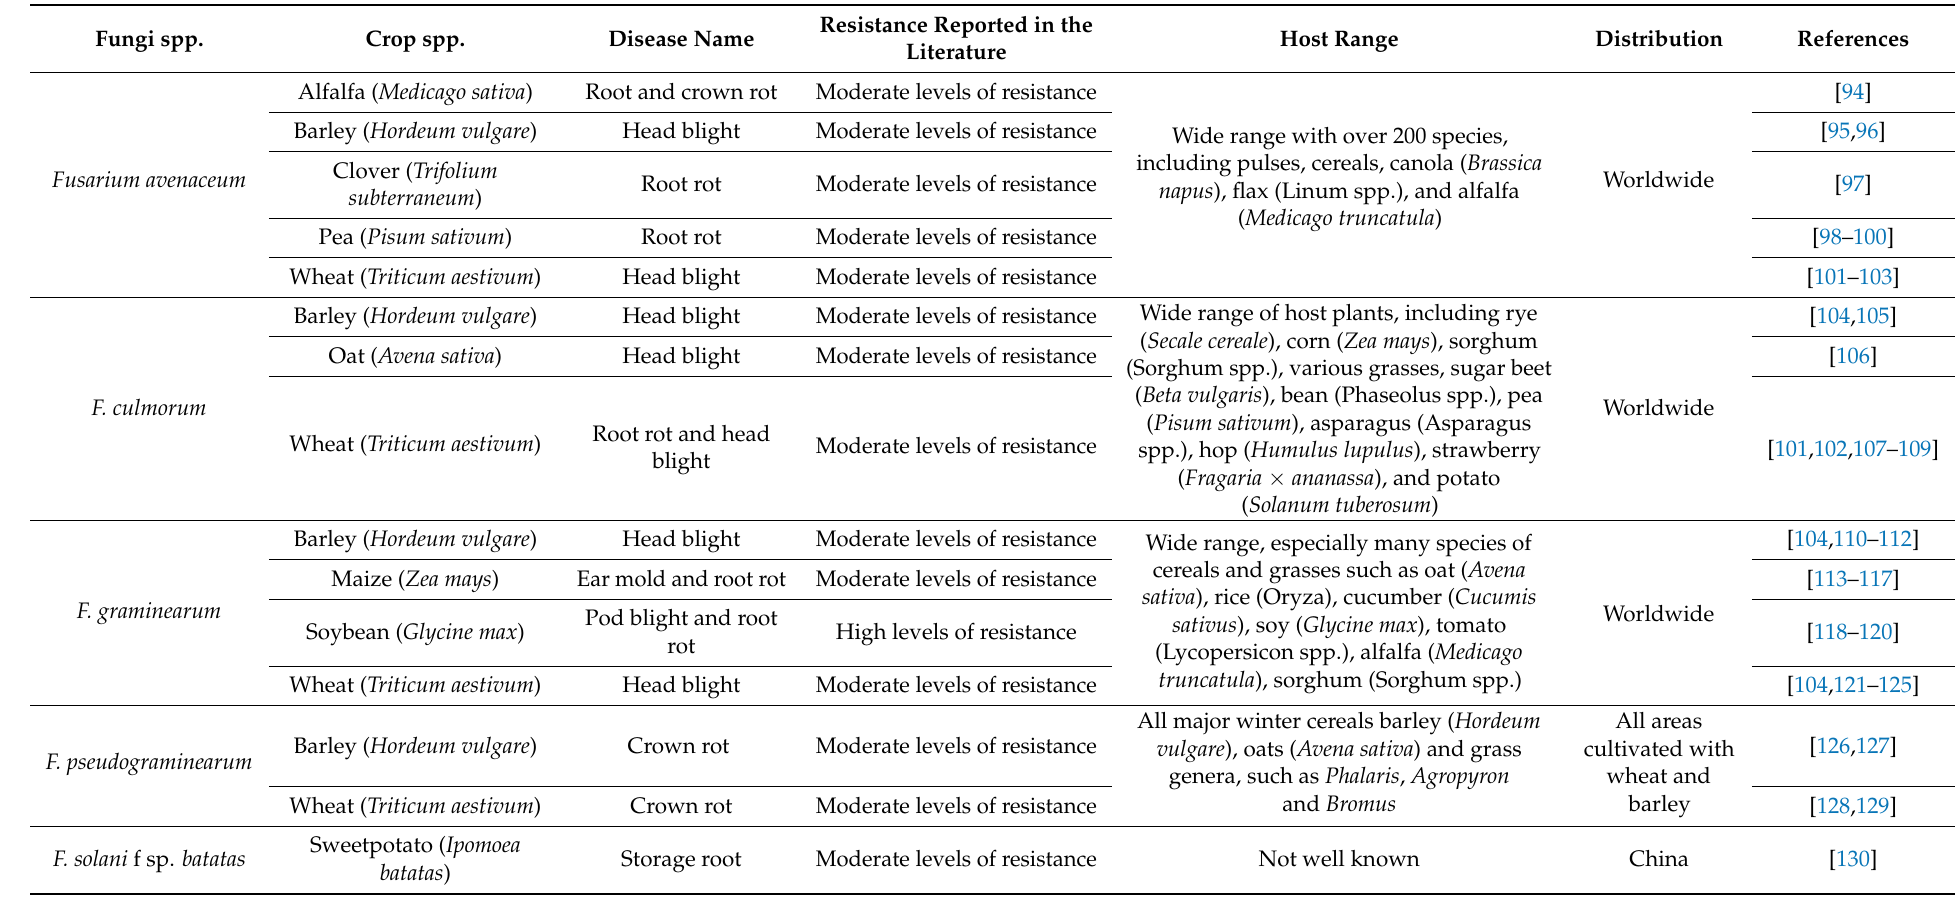
Table 2. A summary of the main crop species affected by Fusarium root